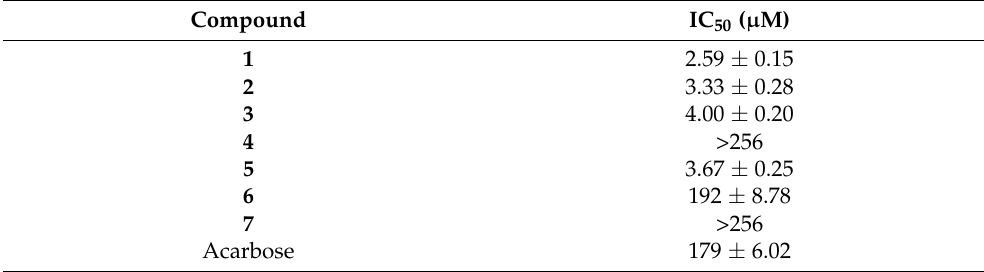
Table 2. α -Glucosidase inhibition (IC 50 ± SD) of 1 – 7